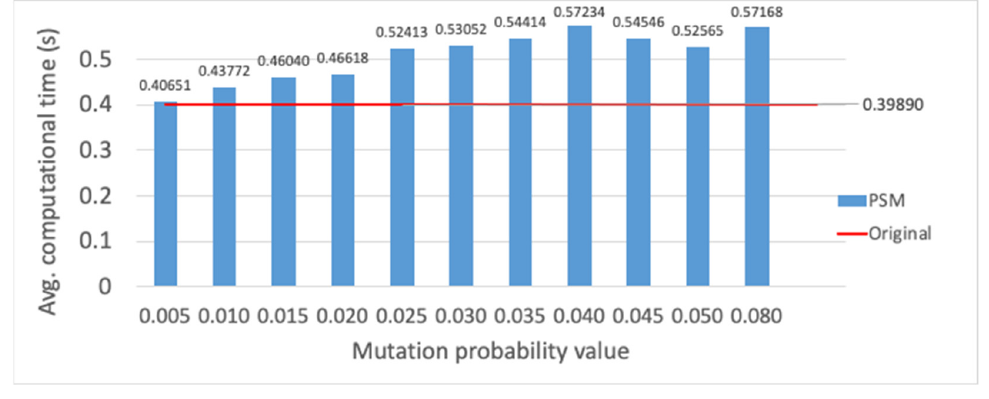
Figure 18. Average computational time (s) for SM method vs. different mutation probability values. Lastly, results are presented for RSM in Figures 19 and 20. Again, different lengths for the segment of genes to be swapped have been considered; remind that RSM consists of randomly choosing two points on the individual, and swapping the segment of genes